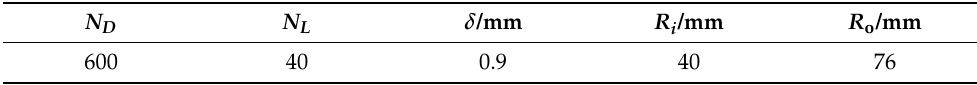
Table 1. Parameter values of RPB used in the